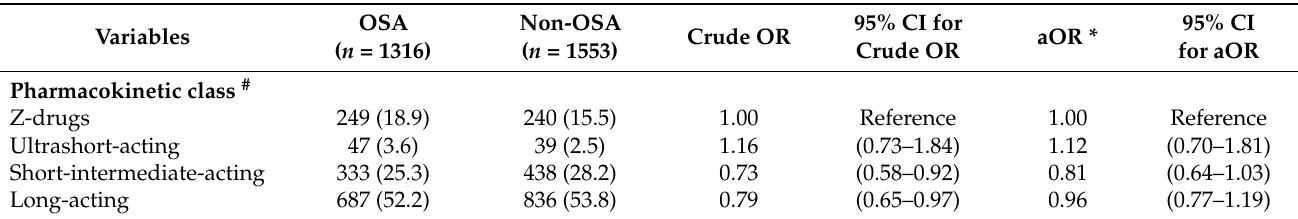
Table 4. Association of BZRAs based on different pharmacokinetic properties and risk of OSA development ( n = 2869, excluded 827 subjects who had an exposure of more than one